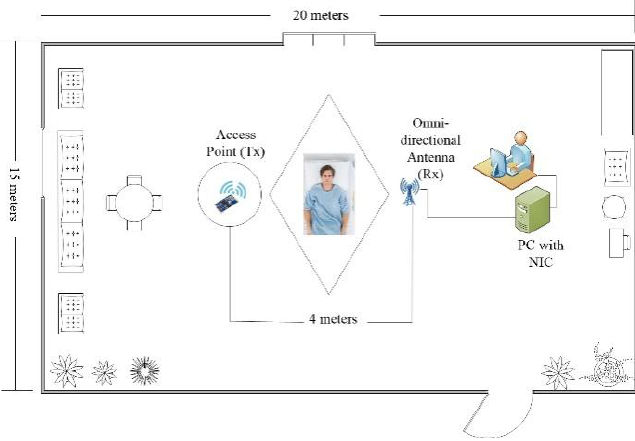
Figure 1. Implemented design overview to monitor breathing.